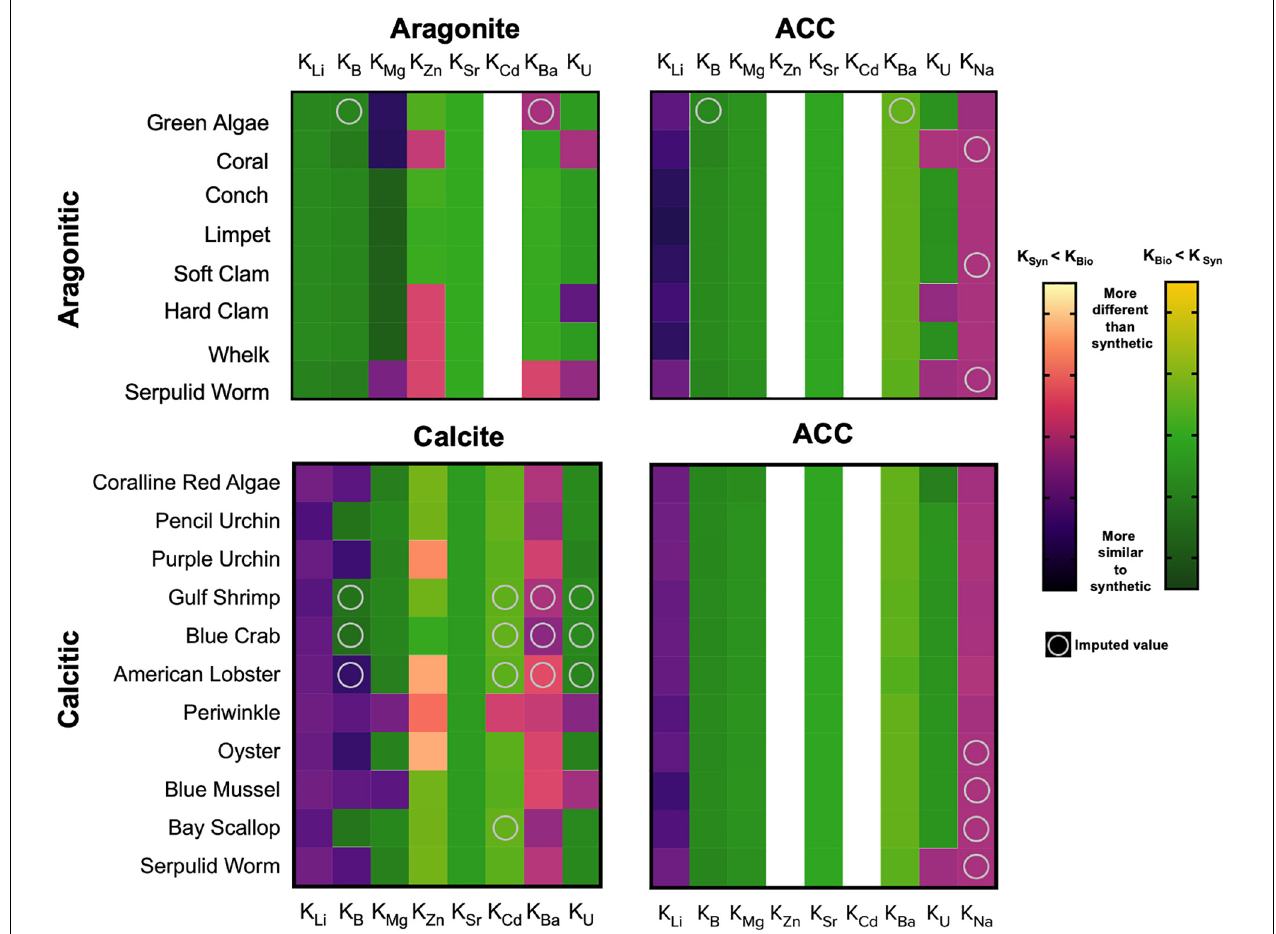
FIGURE 3 | Heatmaps displaying the log10-transformed differences between apparent partition coefficients and published partition coefficients from inorganic mineral precipitation experiments (See Table 2 for values; Supplementary Table 5 for experimental conditions and citations for inorganic values). The apparent elemental partition coefficients calculated for the cultured species studied typically do not align with values derived from synthetic minerals, and species belonging to the same phyla appear to exhibit similar patterns. The warm color gradient (i.e., the left, yellow-black gradient) represents when biogenic carbonates are enriched in an element relative to the published synthetic values ( K Synthetic < K Biogenic). Alternatively, a green-yellow color gradient (i.e., the right gradient) represents when biogenic carbonates are depleted relative to the published synthetic values ( K Biogenic < K Synthetic). White pixels indicate that no published, synthetic values for that element were found. Circles within pixels denote imputed values (See section “Imputation, Hierarchical Clustering, and Ordination” and Figure 4 for details). Apparent partition coefficients were calculated by dividing the measured and imputed elemental ratios of the biogenic carbonates by established seawater minor and trace element concentrations (Bruland, 1983). The top row of panels presents the aragonitic organisms, while the bottom panels represent the calcitic organisms. The label above each panel denotes the inorganic, synthetic partition coefficients being compared to (i.e., aragonite, calcite, and amorphous calcium carbonate; ACC). The color of the pixels was determined by log10(| K X, Biogenic – K X, Synthetic|). The absolute value is used since y cannot be less than 0 in